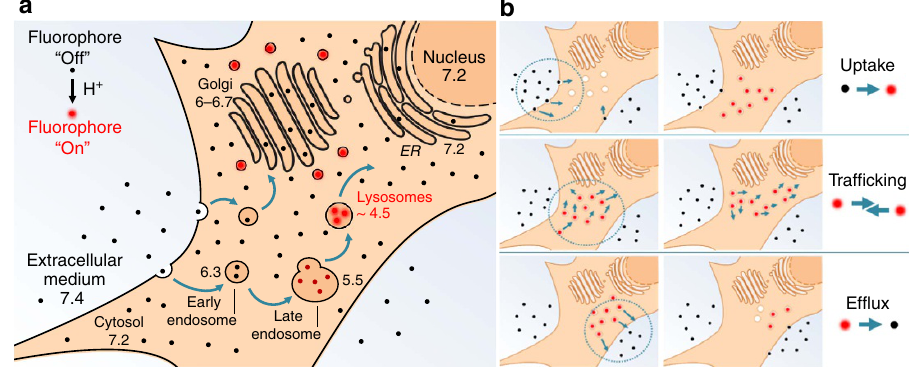
Figure 2 | Cellular uptake responsive NIR-fluorophore. ( a ) Simplified endocytosis of a responsive NIR fluorophore. Numbers represent the approximate pH of the corresponding organelles. ( b ) Three observable stages of the path of the pH-responsive fluorophore in the cellular environment: uptake, trafficking and